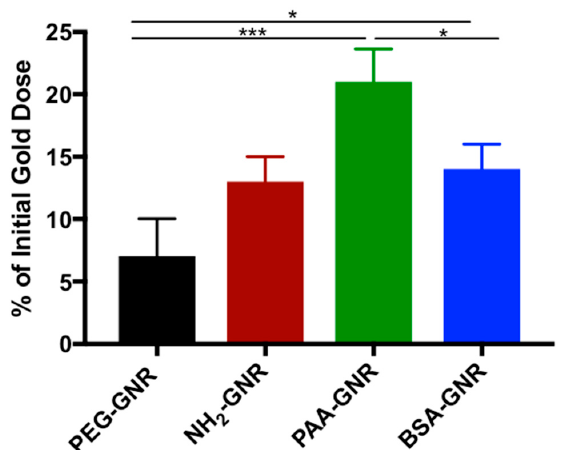
Figure 3. Percentages of GNR of different surface modifications accumulated into human dermal fibroblasts after 2 h of incubation. Data are presented as mean ± SD. One-way ANOVA was used to estimate the statistical differences; * p < 0.05, ** p < 0.01 and *** p < 0.001.